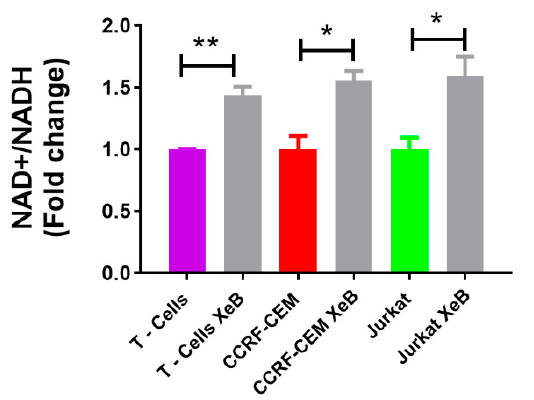
Figure 5 . InsP3R inhibition increases NAD + /NADH ratio in normal and T-ALL cells. Analysis of the NAD + /NADH ratio in normal T cells, CCRF-CEM, and Jurkat cells treated with 5 µM XeB or the vehicle for 4 h. n = 3, mean ± S.E., * p < 0.05, ** p < 0.01 ( t -test).